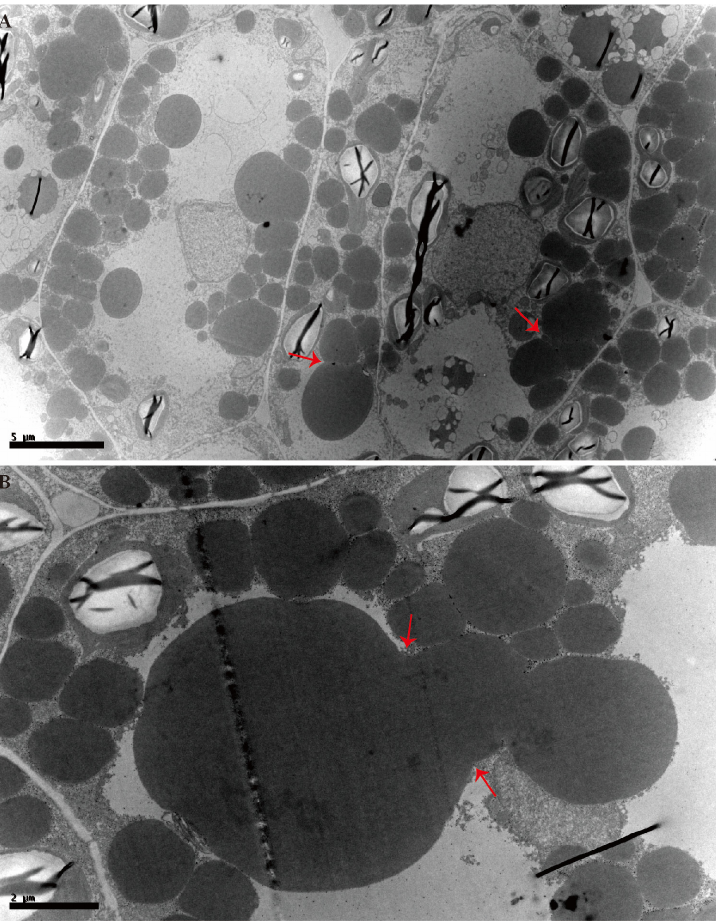
Figure 2. Oversized oil bodies within developing seeds of HOC and LOC materials: ( A ) TEM images of seeds taken 30 days after fertilization in HOC materials, bar = 5 µm; and ( B ) TEM images of seeds taken 30 days after fertilization in LOC materials, bar = 2 µm. Red arrows indicate that oil body aggregation might occur in developing seeds.